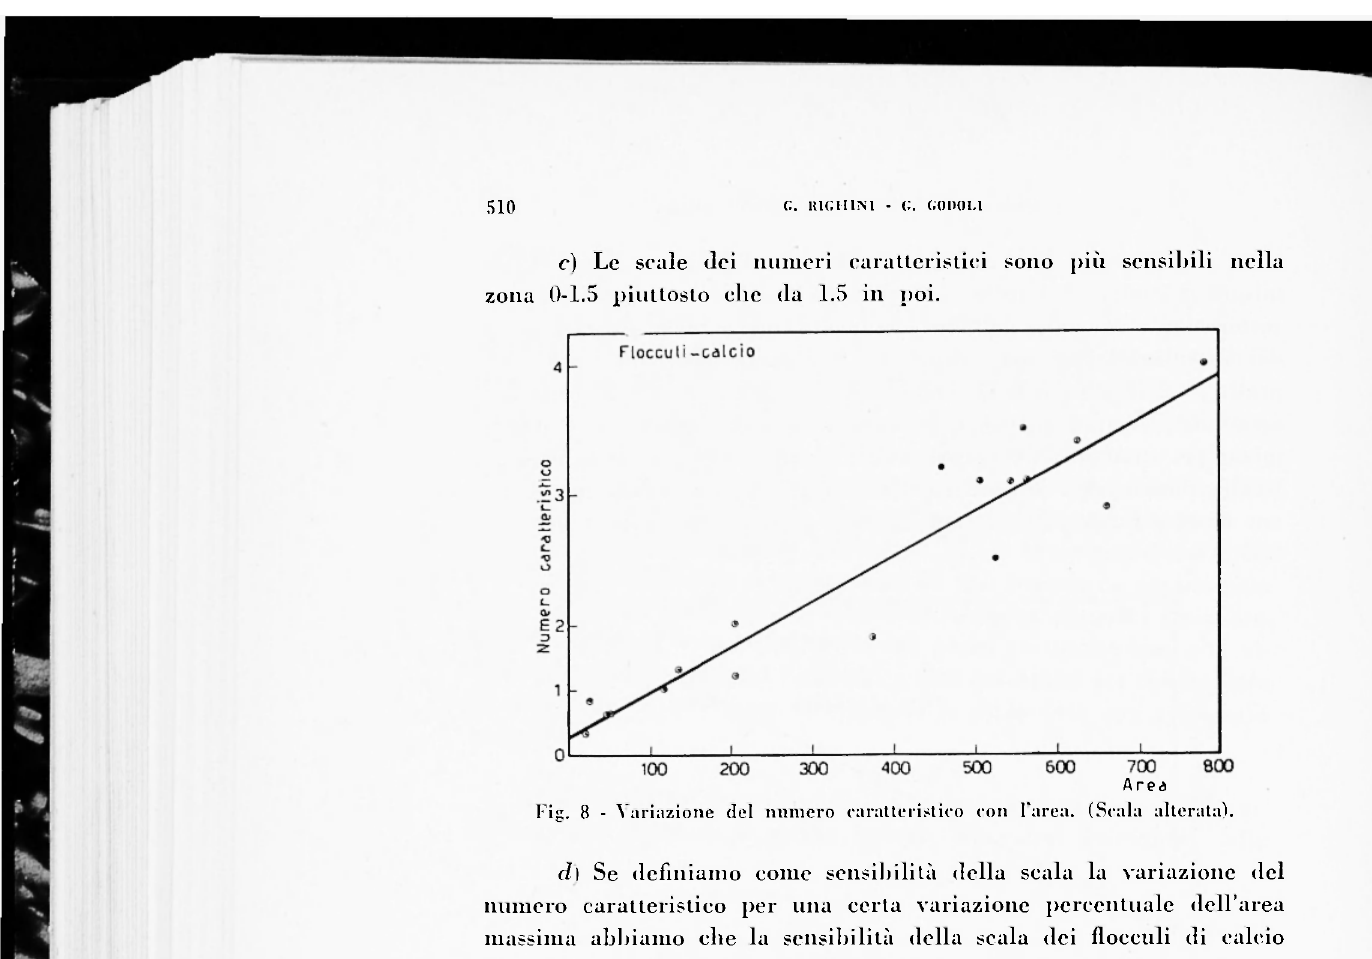
ci) Se definiamo come sensibilità della scala la variazione del numero caratteristico per una certa variazione percentuale